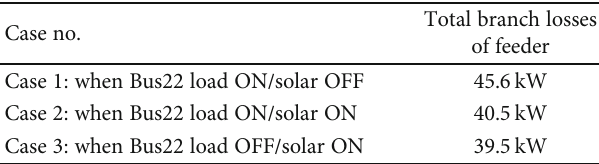
Table 13: Branch losses for Case 3.